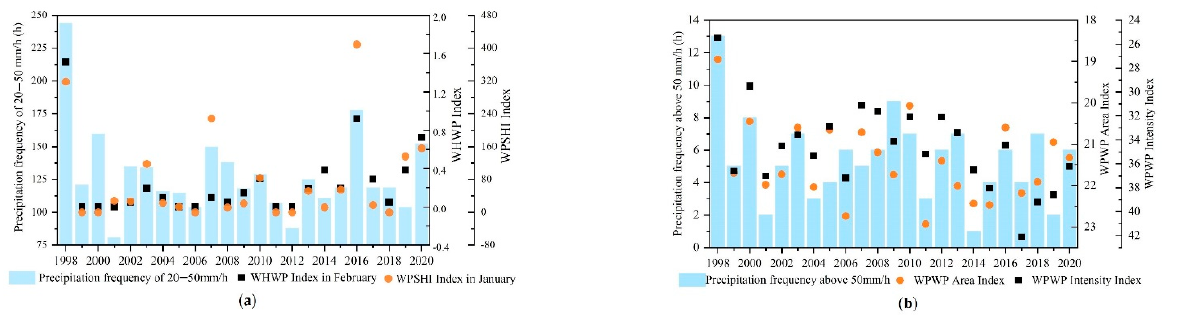
Figure 9. Schematic diagram of correlation between ( a ) heavy precipitation and ( b ) extreme heavy precipitation frequency and climate factors.